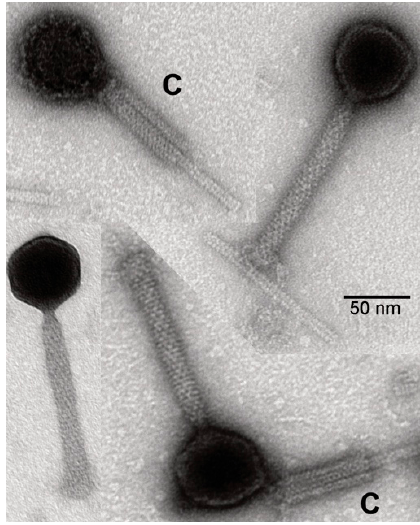
Figure 1. Morphology of ChaoS9 particles by negative-stain electron microscopy. Purified virus was fixed with 2.5% glutaraldehyde, negatively-stained with 1% uranyl acetate and examined under a Zeiss EM 912 electron microscope. Scale bar represents 50 nm. Examples of contracted tails (labeled with a C) are shown in the top left-hand corner and the bottom right-hand corner.